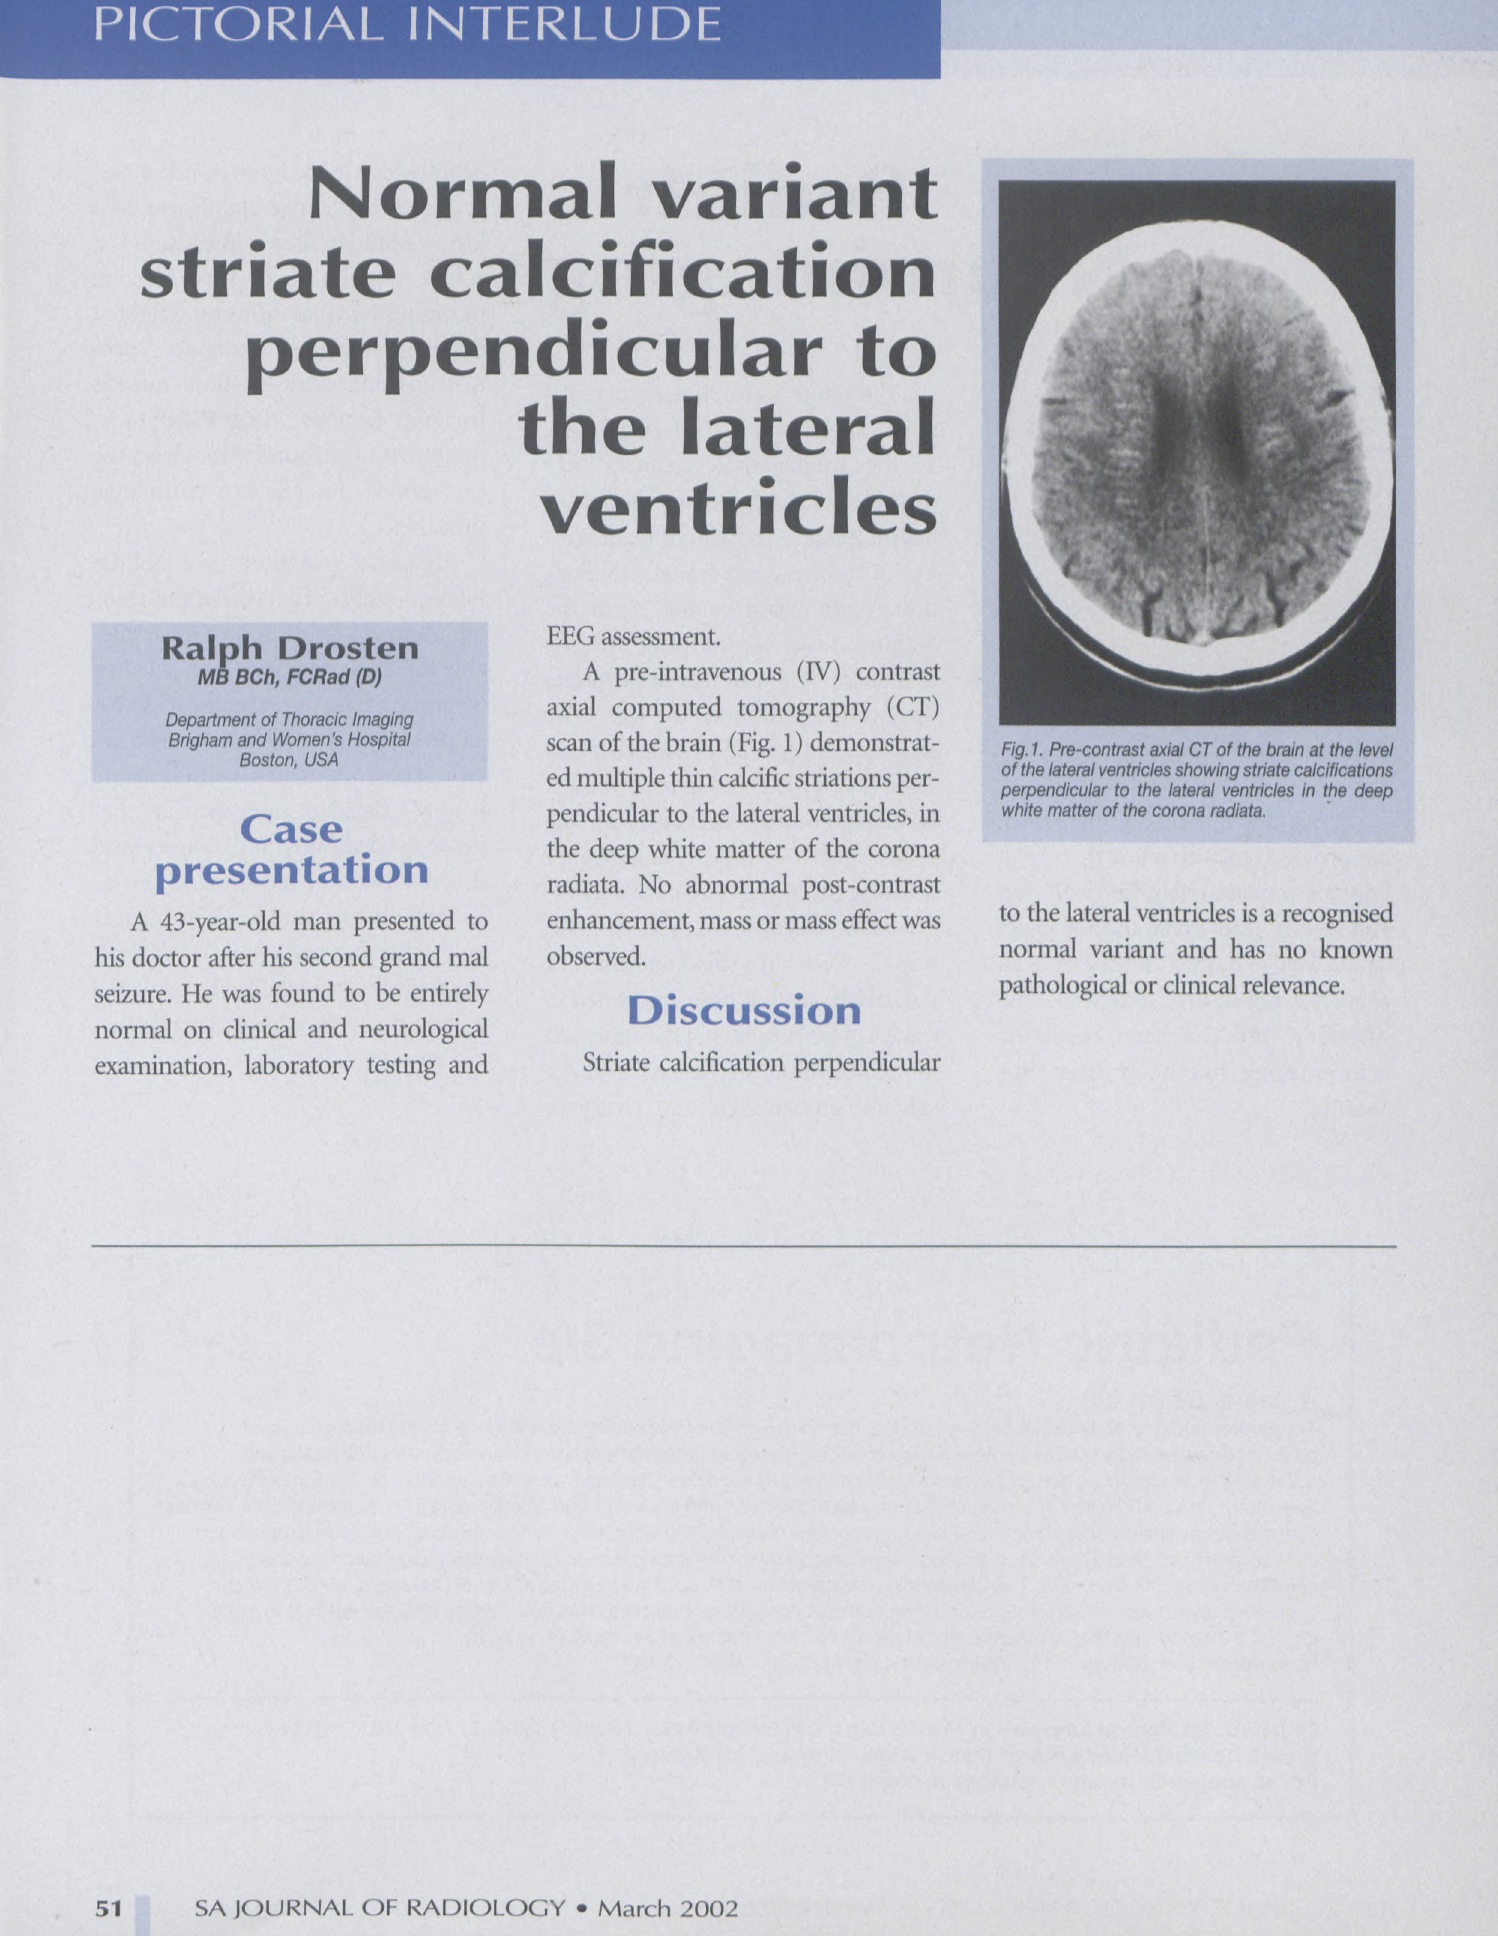
Fig. 1. Pre-contrast axial CT of the brain at the level of the lateral ventricles showing striate calcifications perpendicular to the lateral ventricles in the deep white matter of the corona radiata. -